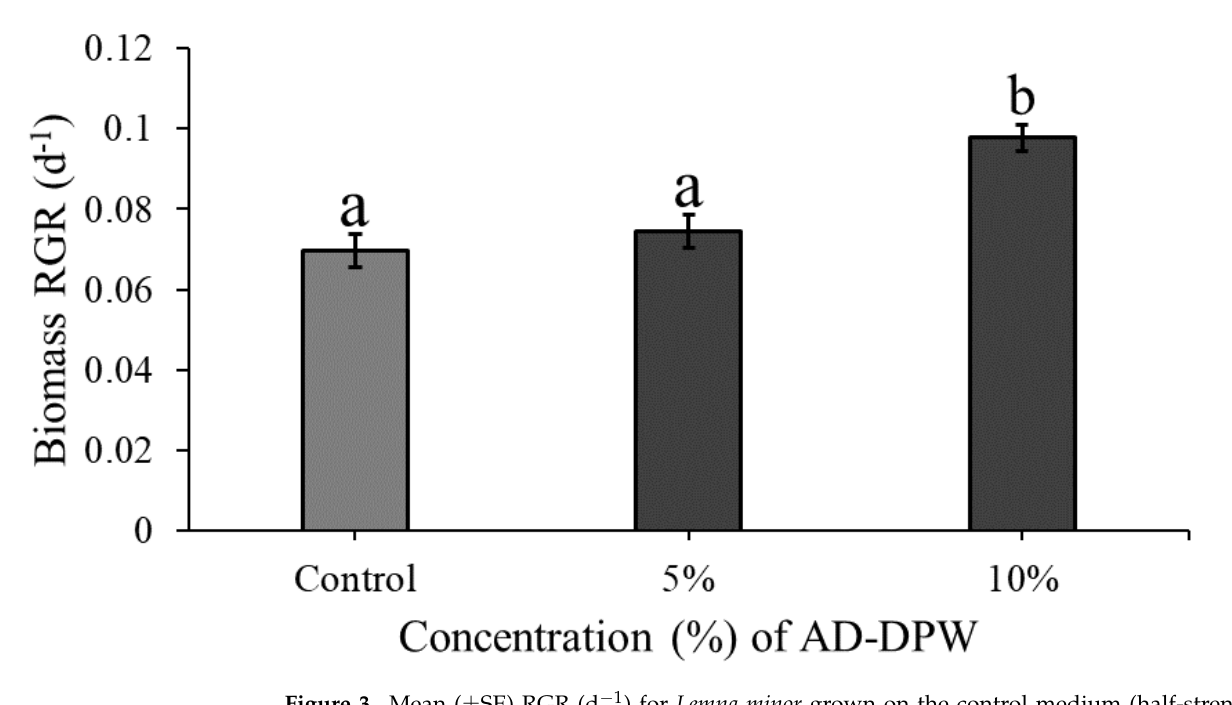
Figure 3. Mean ( ± SE) RGR (d − 1 ) for Lemna minor grown on the control medium (half-strength Hutner’s medium), 5% and 10% AD-DPW in the semi-outdoor, recirculating system. Bars that do not share the same letter significantly differ from one another for p < 0.001, as per the post hoc test.